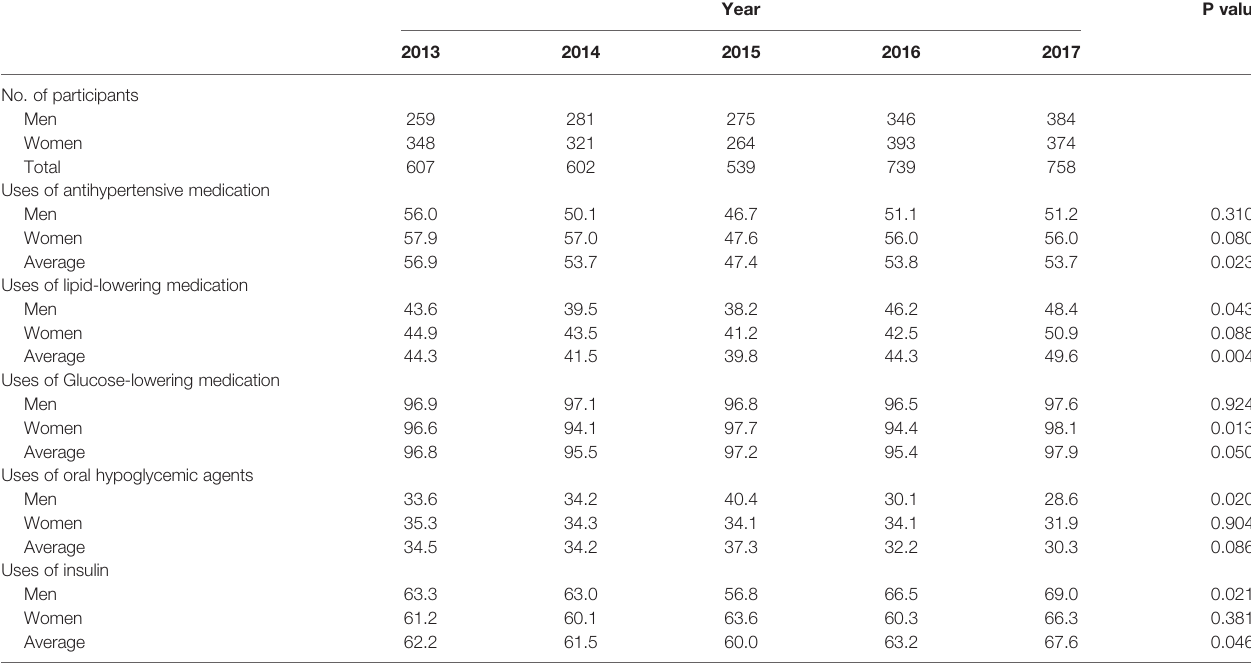
TABLE 5 | Percentage of uses of medication from 2013 to 2017 among inpatients with type 2 diabetes.